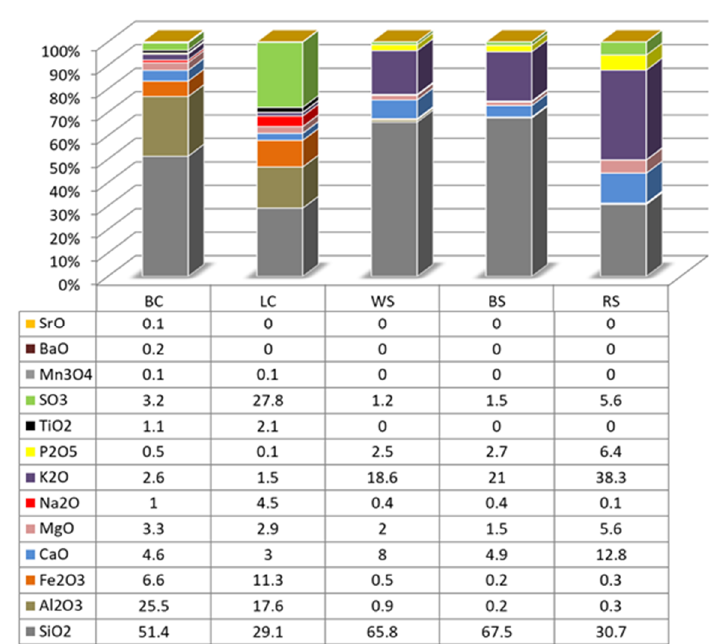
Figure 6. Composition from the ash of tested samples (wt.%).